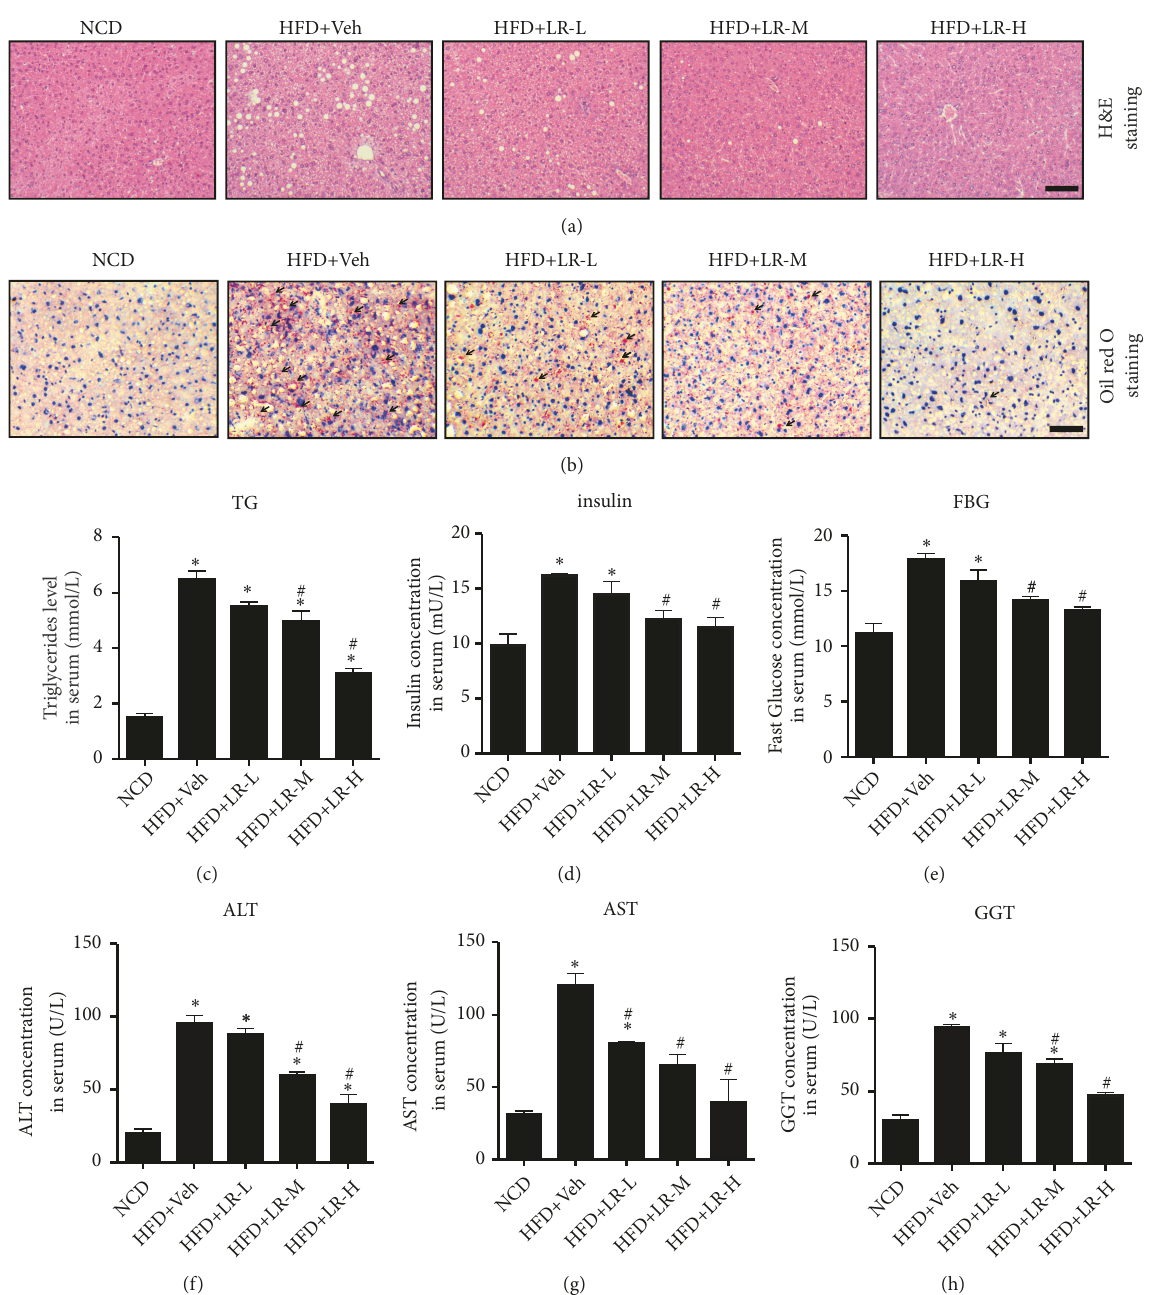
Figure 1: Liraglutide improved hepatic lipid accumulation, metabolic disorder, and liver function in HFD-induced mice model of NAFLD . (a) Liver histology was observed using hematoxylin and eosin staining. The representative images were shown (magnification × 200, scale 20 𝜇 m). (b) Hepatic lipid accumulation was observed using Oil Red O staining. The representative images were shown (magnification × 200, scale 20 𝜇 m). Black arrows indicated lipid droplets. (c, d, e) Metabolic parameters determined by TG, FBG, and insulin concentrations (mmol/L) in serum. (f, g, h) Liver function determined by ALT, AST, and GGT concentrations (U/L) in serum. All serous results presented as means ± SD from six independent experiments. ∗ denotes P < 0.05, versus the NCD group; # denotes P < 0.05 versus the HFD+Veh